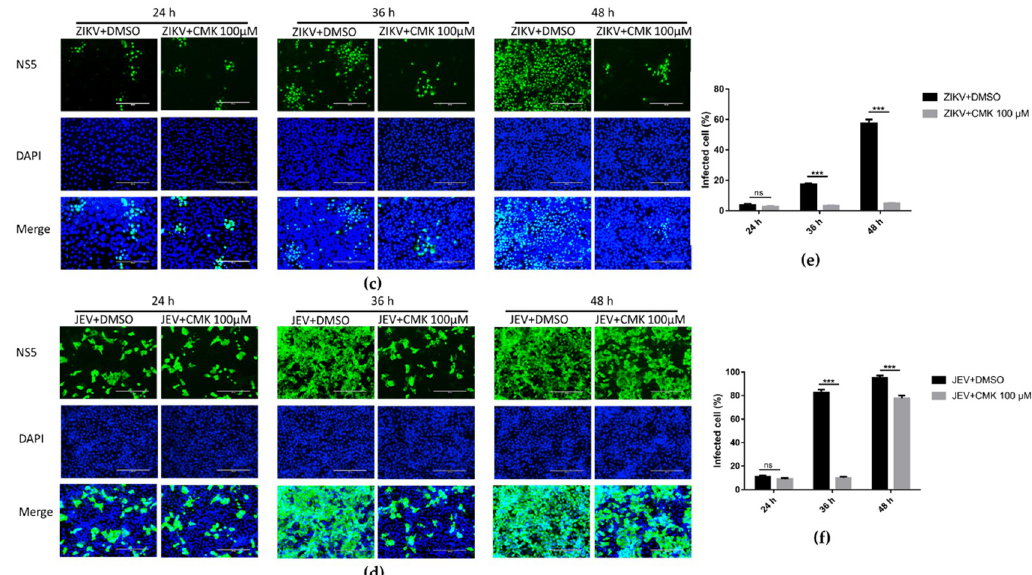
Figure 5. Dec-RVKR-cmk inhibited ZIKV and JEV infection at various time points. Vero cells were infected with ZIKV-0.2 MOI and JEV-0.2 MOI, followed by dec-RVKR-cmk treatment using the 100 µM concentration. Cell supernatant used to determine ( a ) ZIKV and ( b ) JEV viral titer by plaque assay at indicated time points. While immunofluorescence images of ( c ) ZIKV- and ( d ) JEV-infected Vero cells were acquired at different time points in both control (virus + DMSO) and treated (virus + CMK) Vero cells and quantified ( e ) ZIKV and ( f ) JEV immunoreactive positive cells to see the extent of infection. Data are presented as the mean ± SEM from three independent experiments.